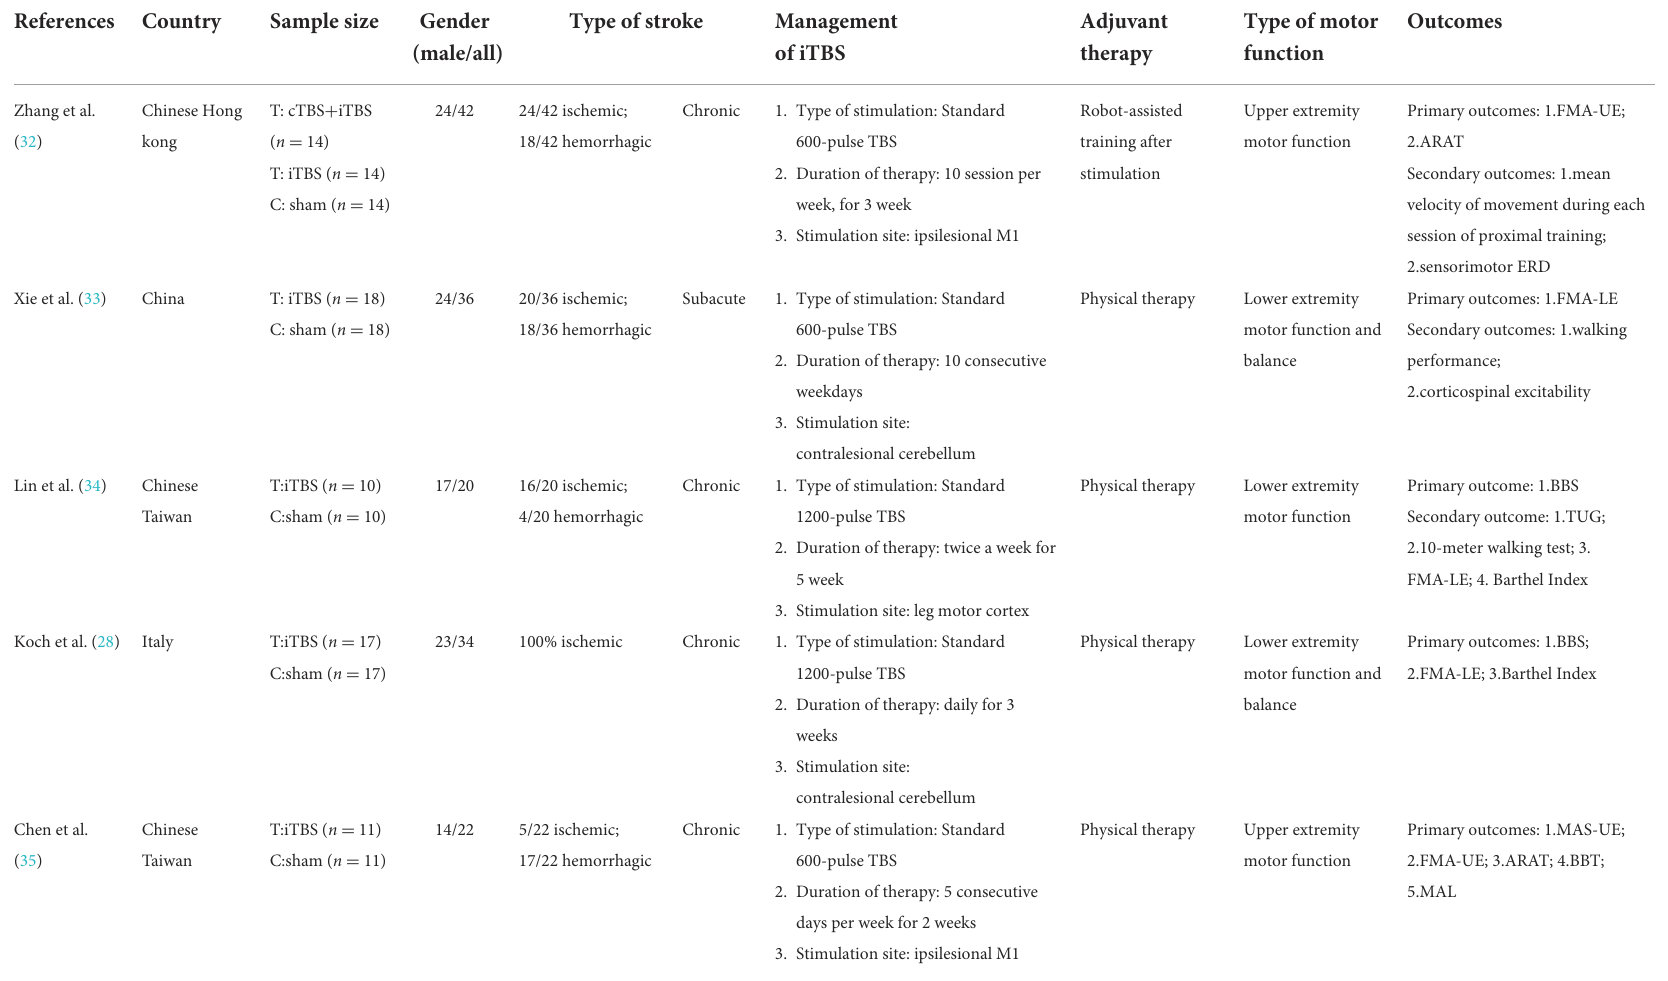
TABLE 1 Characteristics of the included studies and outcome